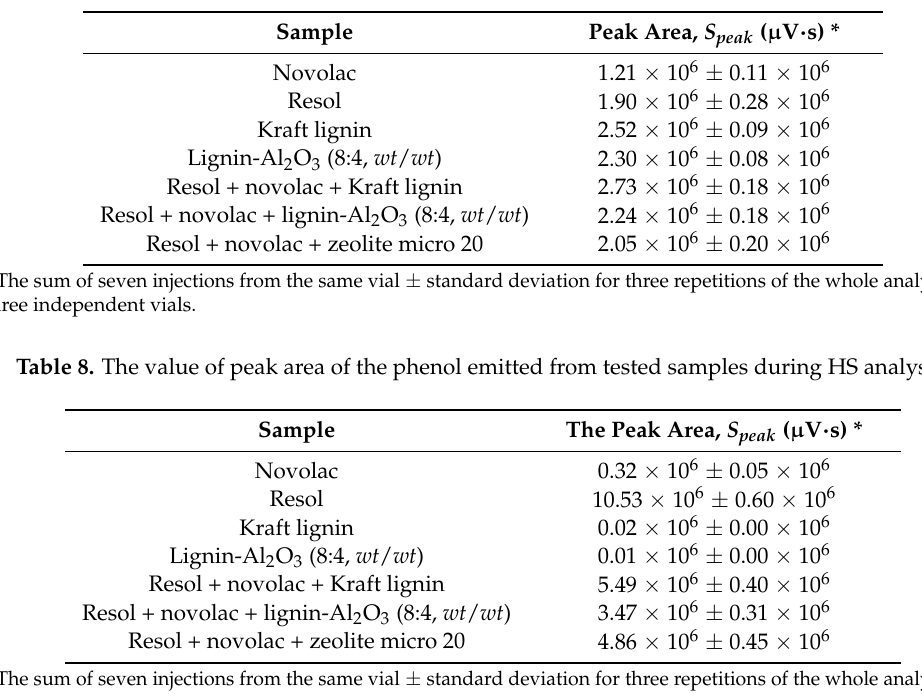
Table 7. The value of peak area of the formaldehyde emitted from tested samples during HS analysis.